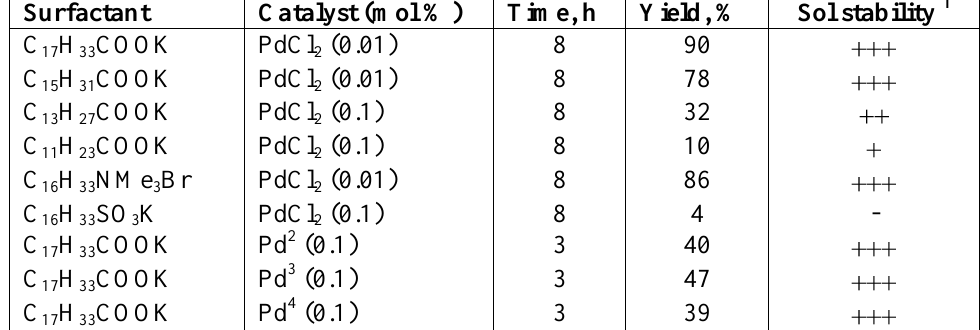
Table 1. The correlation of performance of microemulsion media (surfactant - n-butanol - water) in the Heck arylation with the stability of palladium sol in the same system. Surfactant Catalyst (mol %) Time, h Yield, % Sol stability 1 C H COOK PdCl (0.01) 17 33 2 PdCl 2